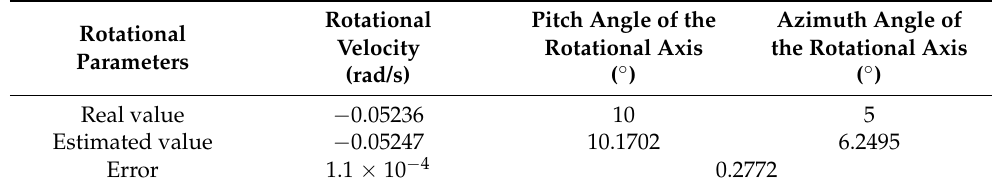
Table 2. Estimation result of rotational parameters of the point model.